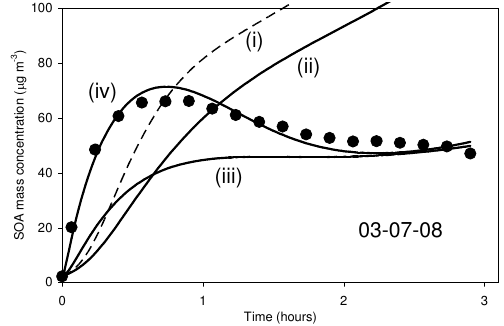
Figure 12. Time profiles of secondary organic aerosol (SOA) mass concentration for ACES 2 Fig. 12. Time profiles of secondary organic aerosol (SOA) mass photo-oxidation experiment 03-07-08. The observed data are shown as points. The lines are 3 concentration for ACES photo-oxidation experiment 03-07-08. The results of simulations using: (i) MCM v3.2 with gas-aerosol partitioning code; (ii) as (i), but 4 observed data are shown as points. The lines are results of sim- with a 6 % yield of OH (and co-radicals) from E(cid:16) caryophyllene ozonolysis; (iii) as (ii), but 5 ulations using: (i) MCM v3.2 with gas-aerosol partitioning code; with gas-aerosol partitioning into observationally-constrained SOA mass loading, and 6 (ii) as (i), but with a 6% yield of OH (and co-radicals) from β - inclusion of wall partitioning with [wall] eff = 1.5 mg m -3 ; (iv) as (ii), but with inclusion of 7 caryophyllene ozonolysis; (iii) as (ii), but with gas-aerosol parti- (illustrative) transient formation of D -hydroxyhydroperoxides (see text) and wall partitioning 8 tioning into observationally-constrained SOA mass loading, and with [wall] eff = 1.5 mg m -3 . 9 inclusion of wall partitioning with [wall] eff = 1.5mgm − 3 ; (iv) as (ii), but with inclusion of (illustrative) transient formation of α -hydroxyhydroperoxides (see text) and wall partitioning with [wall] eff =1.5mgm − 3